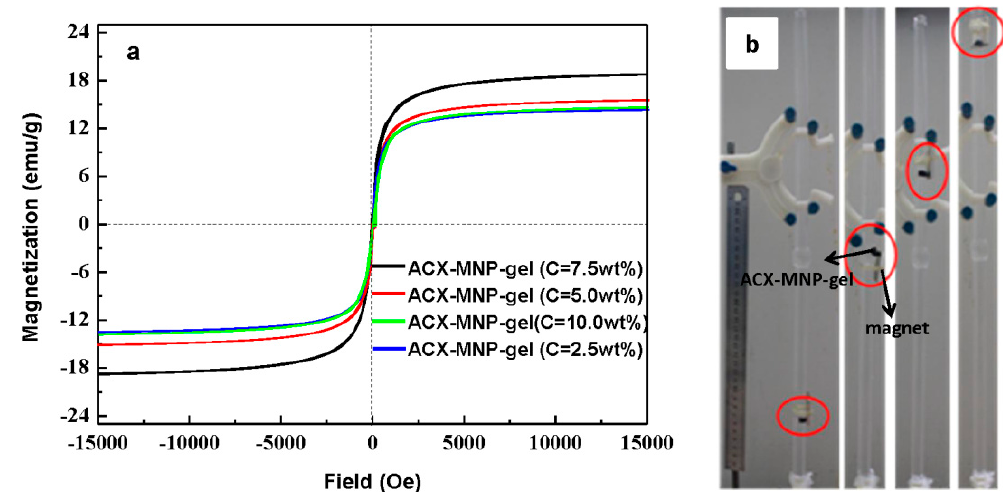
Figure 7. ( a ) The magnetization curve of the dehydrated ACX-MNP-gels loaded with Fe 3 O 4 nanooctahedra; ( b ) Photographs of the ACX-MNP-gels in a quartz tube full of water with a magnet on the outside of the quartz tube.